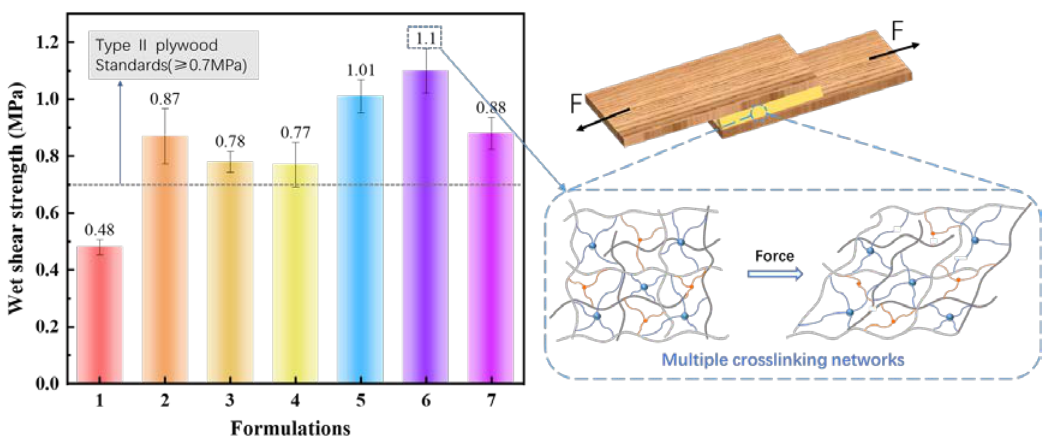
Figure 7. The wet shear strength of plywood bonded by investigated adhesives.